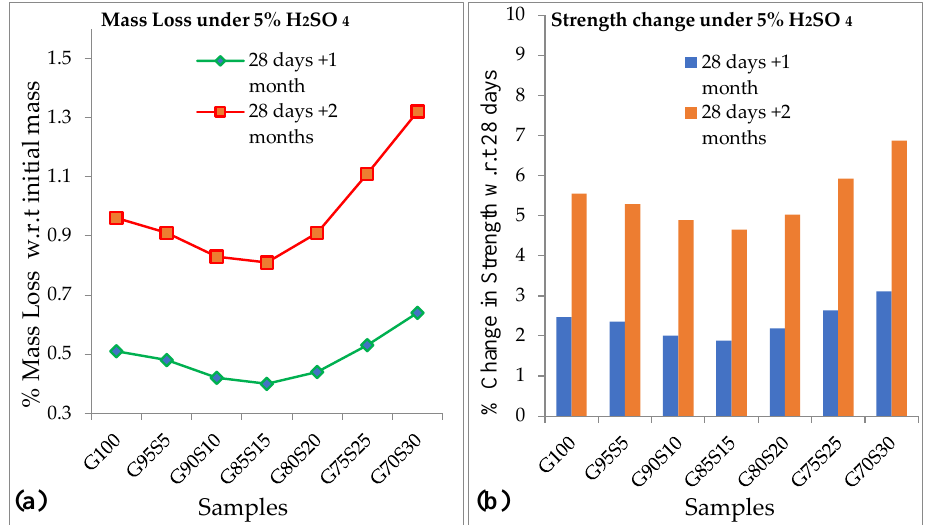
Figure 4. ( a ) Mass loss; ( b ) strength change under 5% H 2 SO 4 solution.